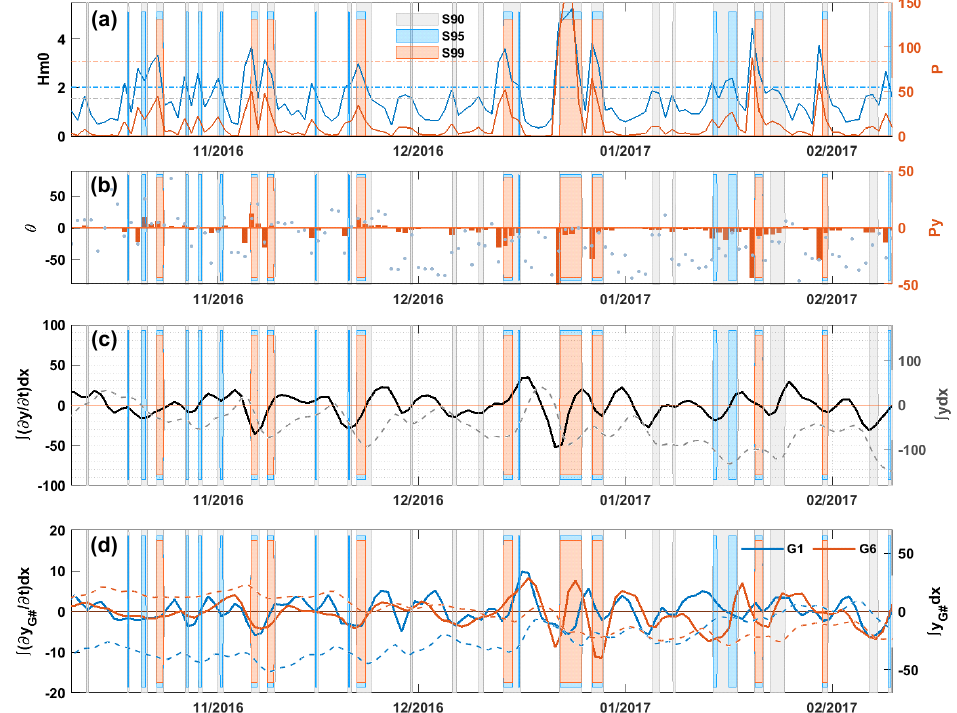
Figure 8. Changes in wave characteristics and beach width during the winter between 2016 and 2017. ( a ) Significant wave height and wave power, ( b ) wave direction and longshore component of wave power, ( c ) longshore transport rate (solid line) and integrated beach width (dashed line), and ( d ) longshore transport rate (solid line) and integrated beach width for sectors G1 and G6 (dashed line).